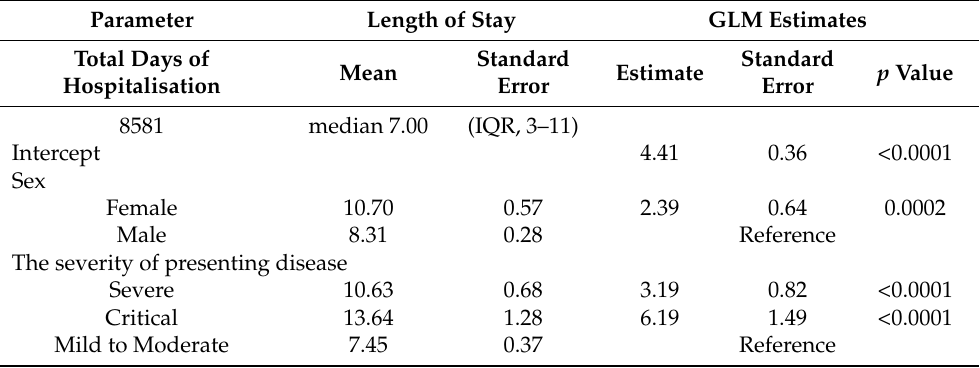
Table 2. Average length of hospital stay and the independent factors associated with the length of hospital stay obtained from the generalized linear model